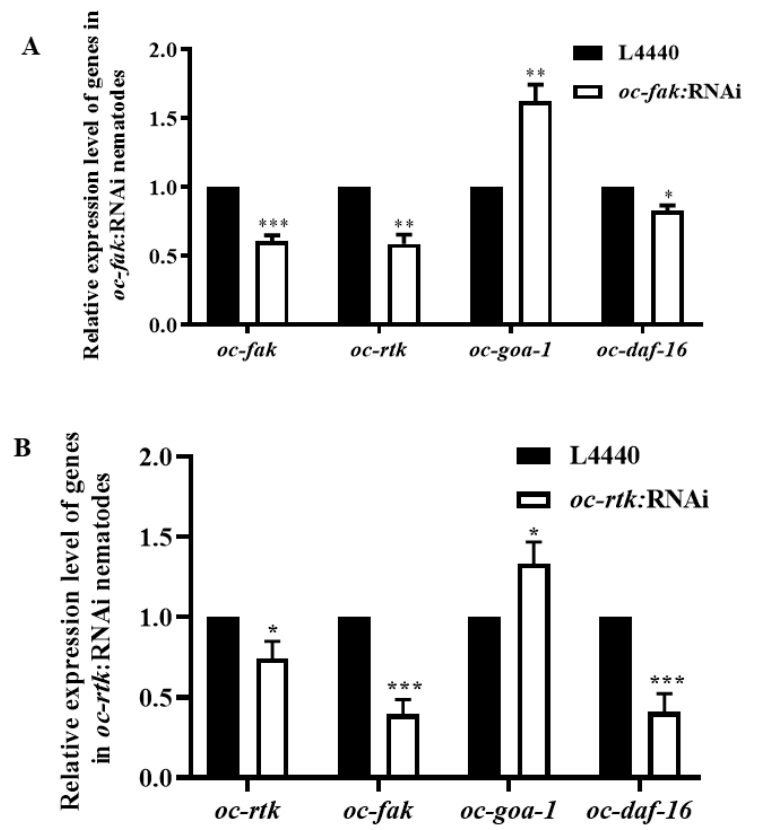
Figure 5. Interaction among the two tyrosine kinases oc-fak and oc-rtk at the transcriptional level, and the influence of them on the expression of oc - daf-16 and oc-goa-1. ( A ) Upregulated expression of oc-goa-1 and downregulated expression of oc - daf-16 and oc-rtk in oc-fak :RNAi O. chongmingensis . ( B ) Upregulated expression of oc-goa-1 and downregulated expression of oc - daf-16 and oc-fak in oc-rtk :RNAi O. chongmingensis . * p < 0.05; ** p < 0.01; *** p < 0.001. 2.5. High-Throughput Sequencing Indicates more than 88.84% MicroRNAs in the Two Combi- nations Were Significantly Differentially Expressed